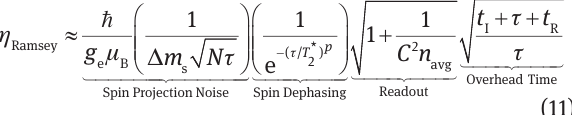
the optical and MW driving fields. The shot-noise-limited sensitivity for DC magnetic fields using a Ramsey pulse